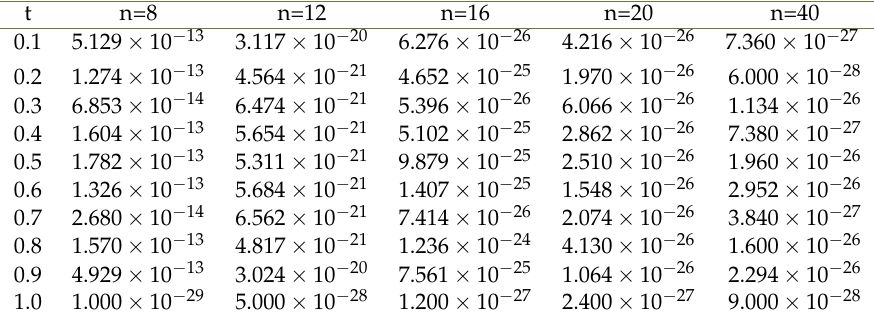
with respect to n = 20, is 3.4 s . From the numerical results, it is clear that the obtained results are in good agreement with the exact solution and similar to the previous example, stability of applied method can be deduced from this table. The computational errors with respect to the trigonometric, exponential and ordinary, cubic B-spline method [41,